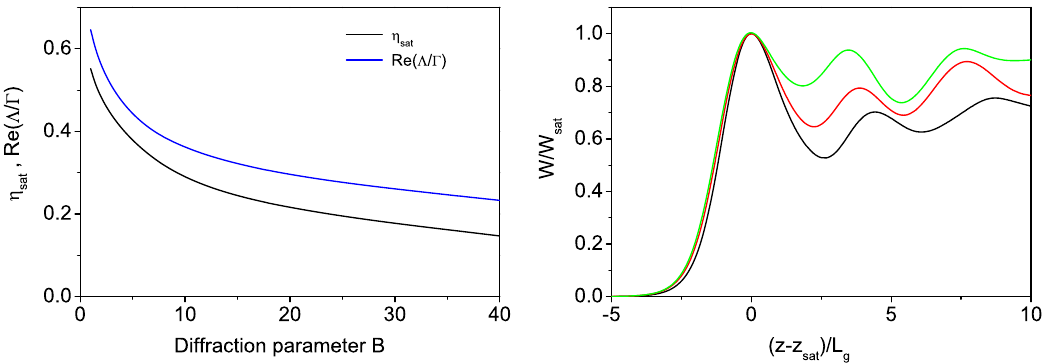
FIG. 1. Operation of the FEL amplifier with untapered undulator. Left plot: FEL field gain Re Λ = Γ (black curve) and FEL efficiency at ¼ W Þ (blue curve) versus the diffraction parameter B . Right plot: Evolution of the radiation power along = ð ρ W the saturation η sat sat beam the undulator. Black, red, green curves correspond to the value of the diffraction parameter B ¼ 1 , 10, and